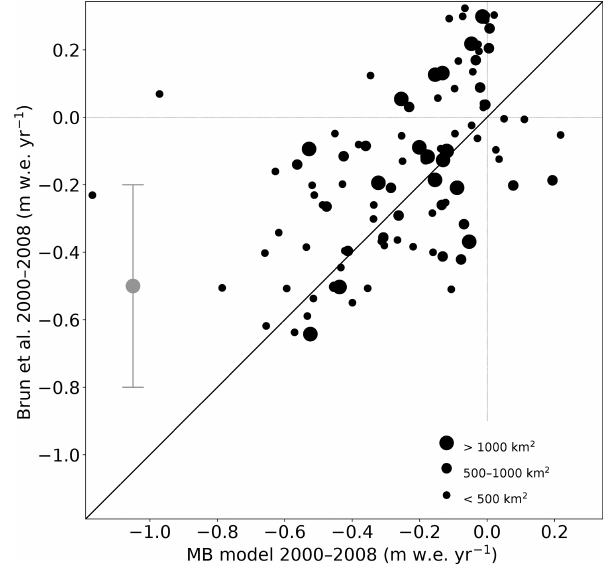
Figure 12. Comparison between mean modelled mass balances from this work, binned on a 1 ◦ × 1 ◦ grid as in Fig. 11, and those derived from observations of Brun et al. (2017), which are on the same grid, between 2000 and 2008. The size of the mean errors in the observed mass balances is illustrated by the grey error